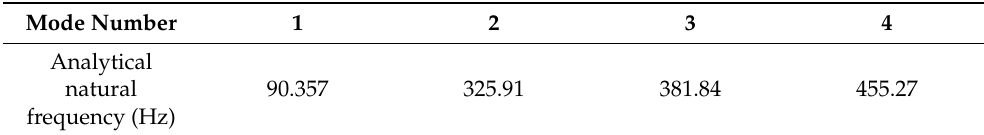
Table 1. Analytical FEM based first 4 natural frequencies in